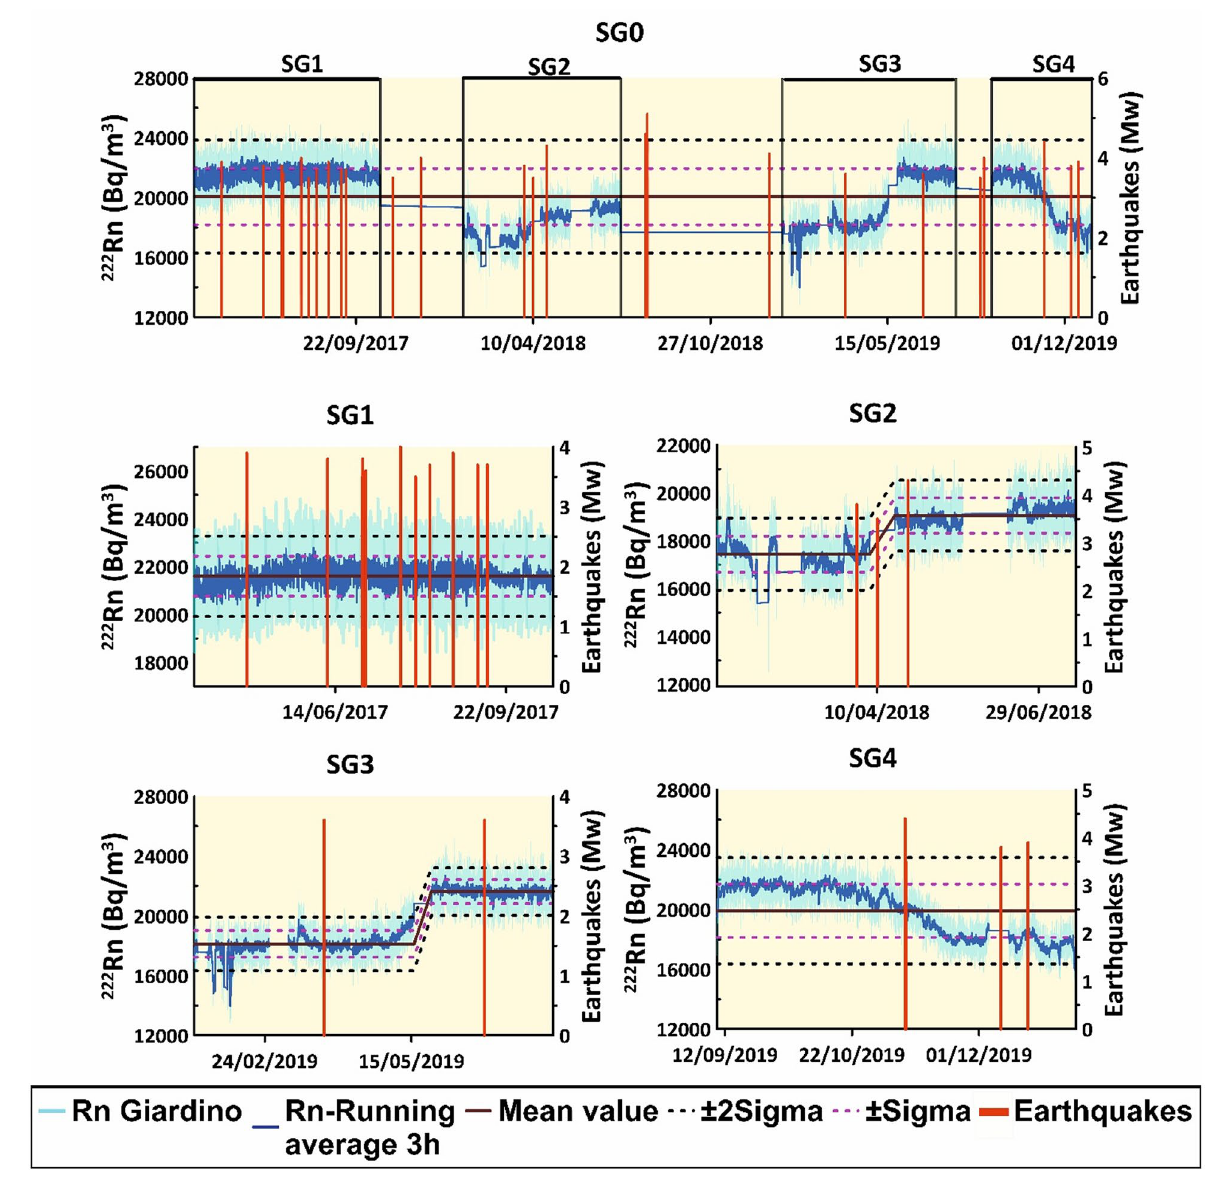
with blue lines. Mean values and the ± σ and ± 2 σ thresholds are dis- played with solid lines and with dashed ones, respectively. Seismic events with M ≥ 3.5 (from the INGV database, available online at w http://terre moti.ingv.it/) are shown with red